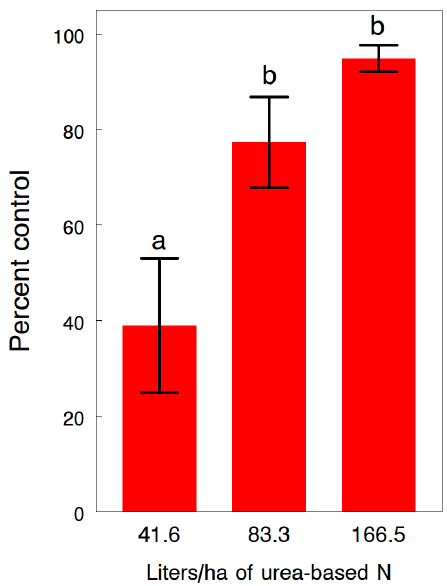
Figure 6. Effects of three rates of urea-based ammonium nitrate solutions applied at night to reduce the percentage and severity of plant damage of the gray garden slug, Deroceras reticulatum , in no-till corn. Treatments were applied at the three- to four-leaf stage and then evaluated the following night between the hours of 11 PM and 2 AM to record the number of slugs per 20 plants from a center row of each paired treated and untreated plot. Percent control was expressed as a reduction in slug density relative to the density in the paired untreated plot. Pairs of means ( ± SEM) with different letters are significantly different at the 5% probability